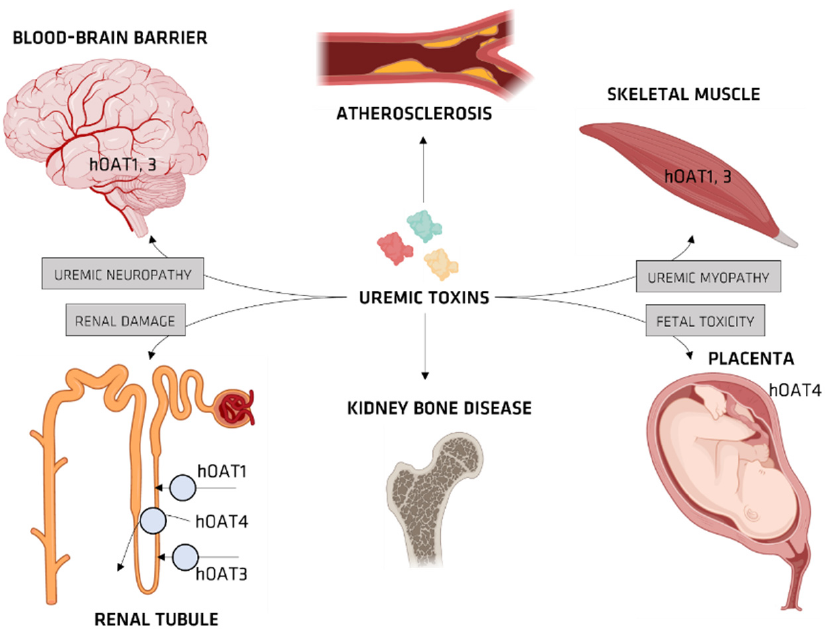
Figure 8. Pathological role of organic anion transporters (OATs) in the progression of uremia, atherosclerosis, and kidney bone disease.